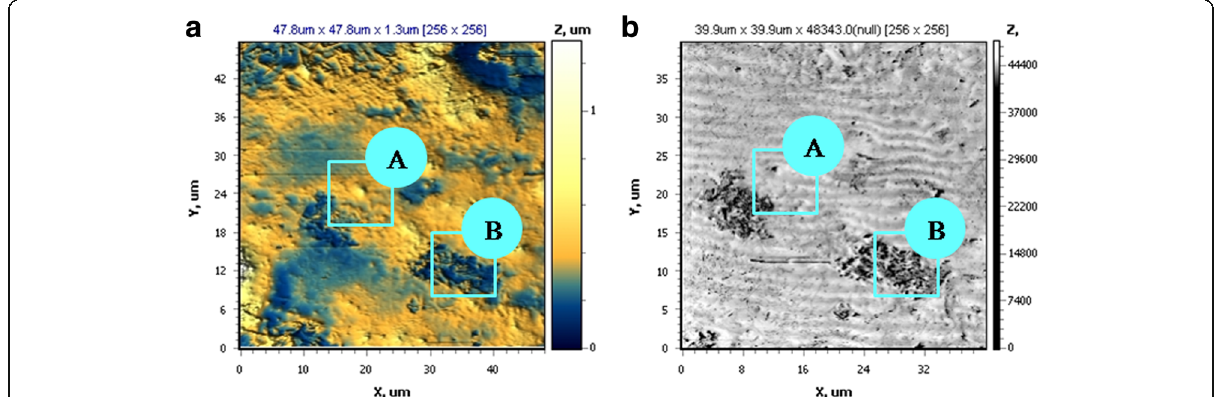
Fig. 9 a 2D topography and b 2D torsion maps of the surface for Fe-Co-Mo coating on mild steel substrate with thickness of 10 μ m deposited in pulse